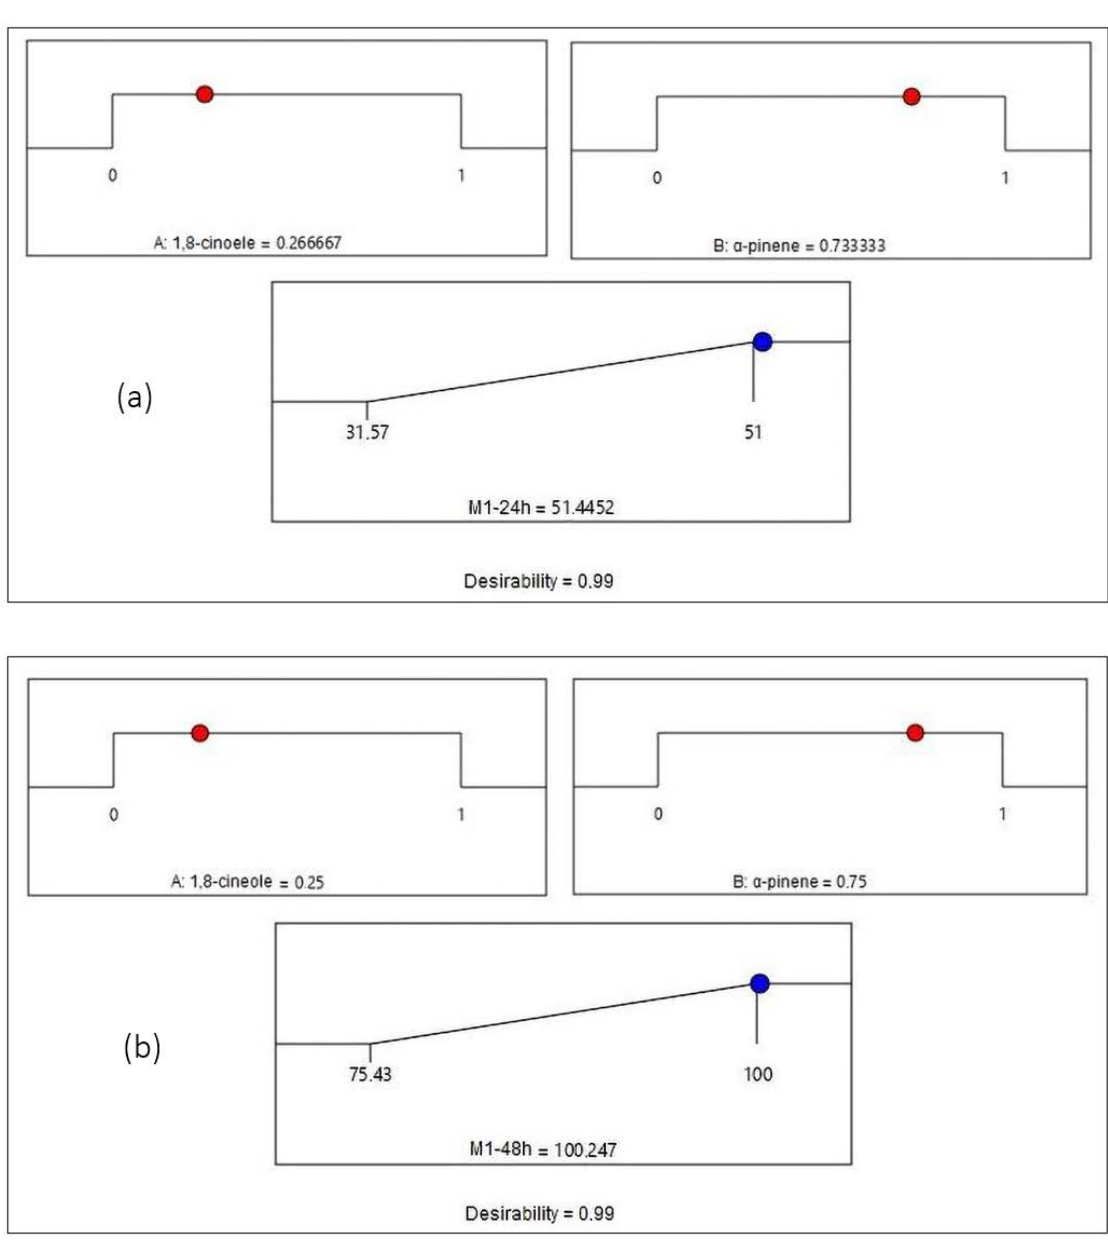
Figure 4. Desirability profile of optimal conditions to maximize the mortality rate for Mixture 1 ( a ) at 24 h and ( b ) at 48 h. (A) 1,8-cineole; (B) α -pinene.